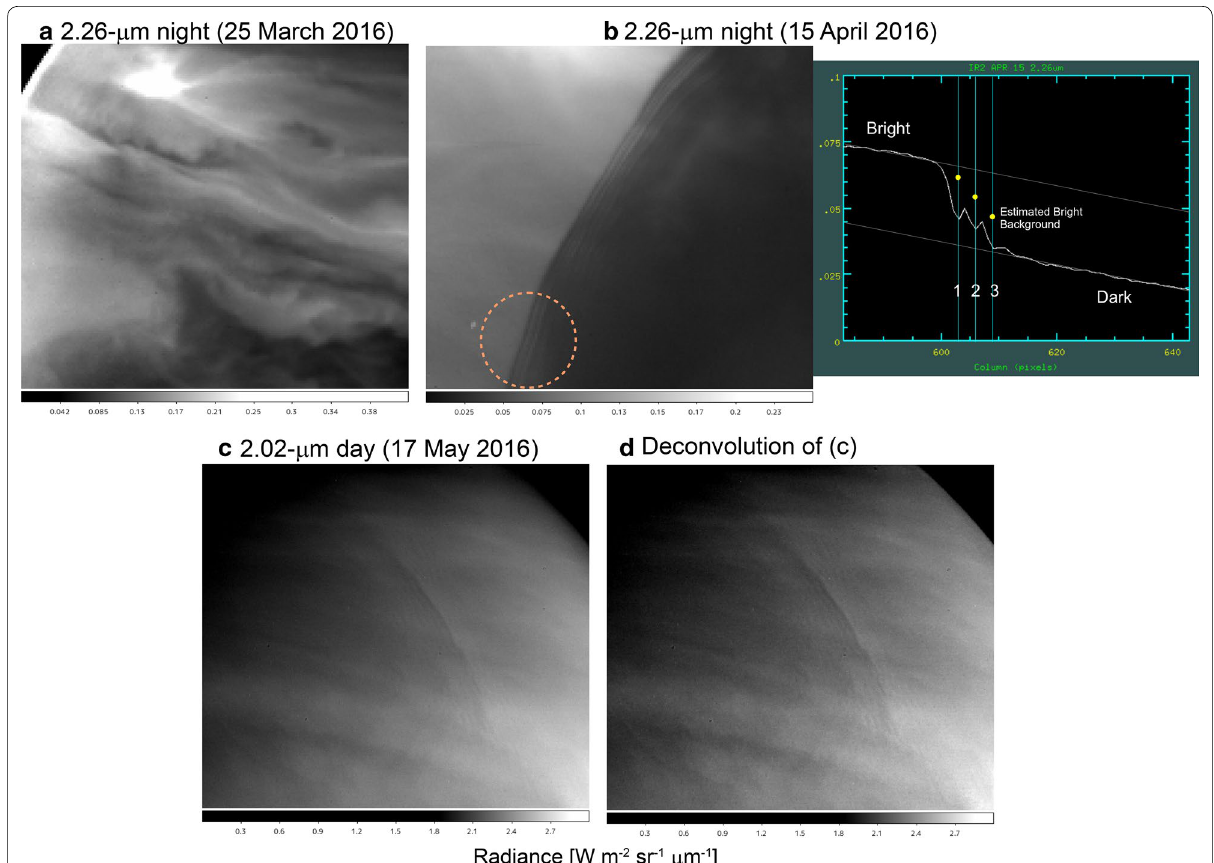
Fig. 11 Example images with IR2. a A 2.26‑μm night‑side image (March 25, 2016), exhibiting complex atmospheric dynamics. The black triangle in the upper‑left corner includes “negative” pixels after subtraction of a synthetic dayside image to remove the contamination. b A 2.26‑μm night‑side image (April 15, 2016), showing an unusually sharp contrast boundary and a fine structure. (See text for the explanation of the intensity profile.) c A 2.02‑μm dayside image (May 17, 2016), showing topography‑originated (Beta Regio) cloud features. Many fainter features are seen in parallel to